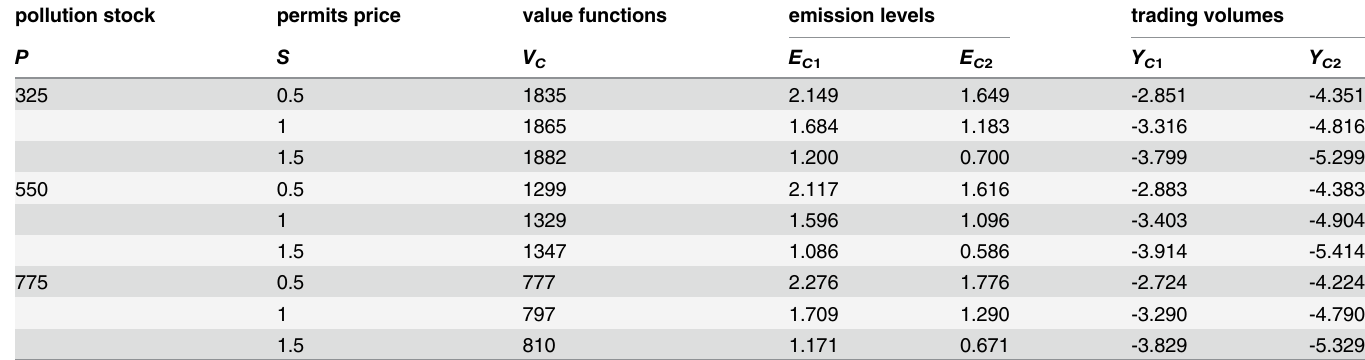
Table 3. The cooperative game at t = 0. pollution stock permits